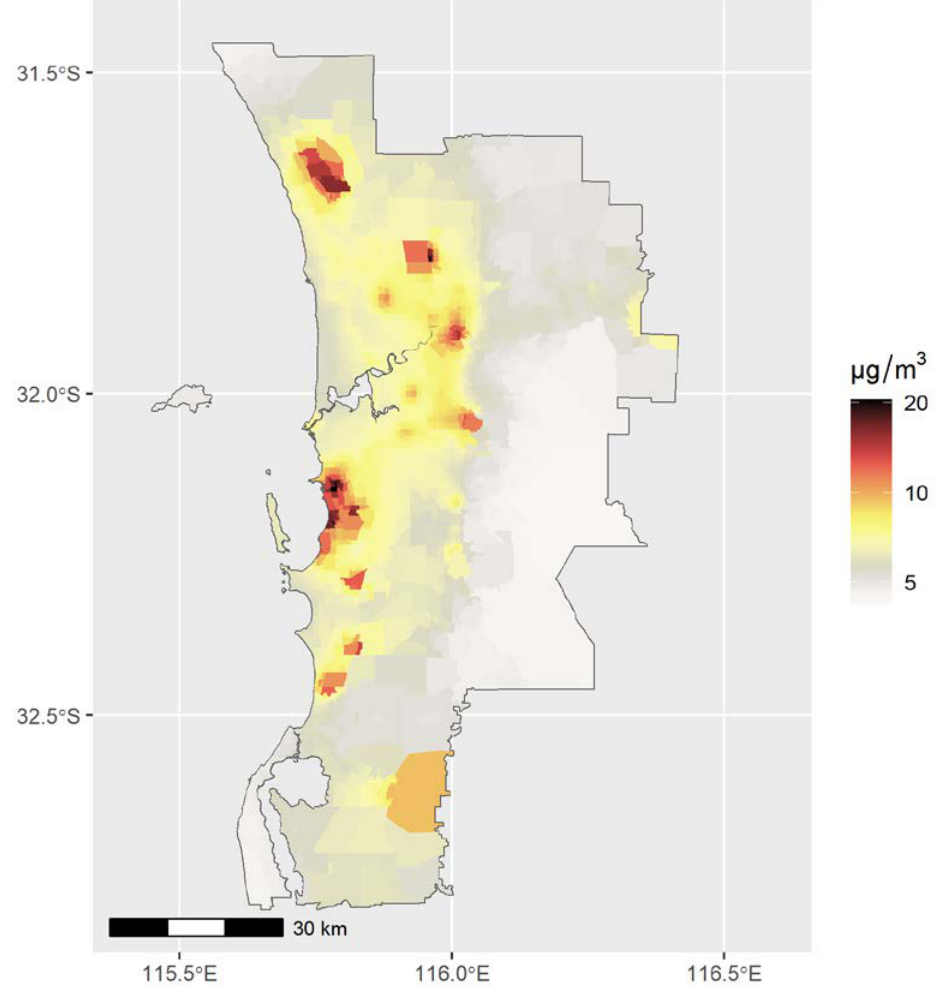
Figure 3. Baseline annual mean PM 2.5 (PM bc ) for GMR Perth generated by the CCAM-CTM from the baseline emissions inventory and extracted to ABS mesh blocks.